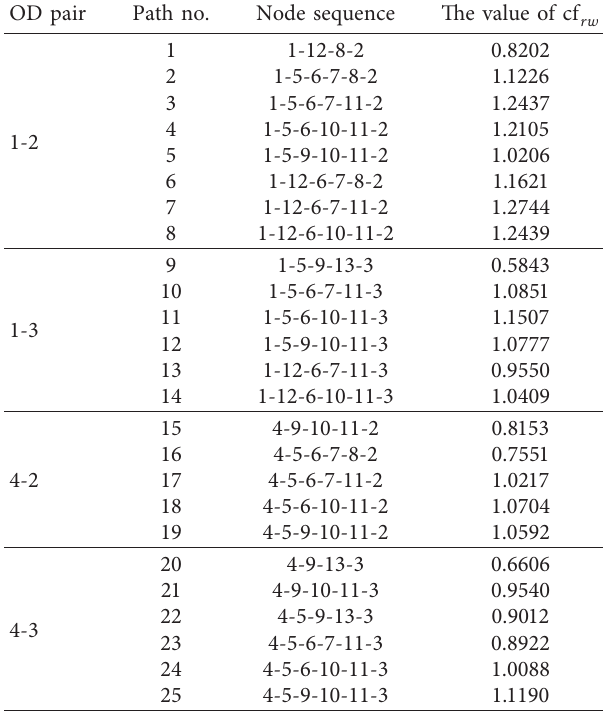
Table 5: Parameters between four OD